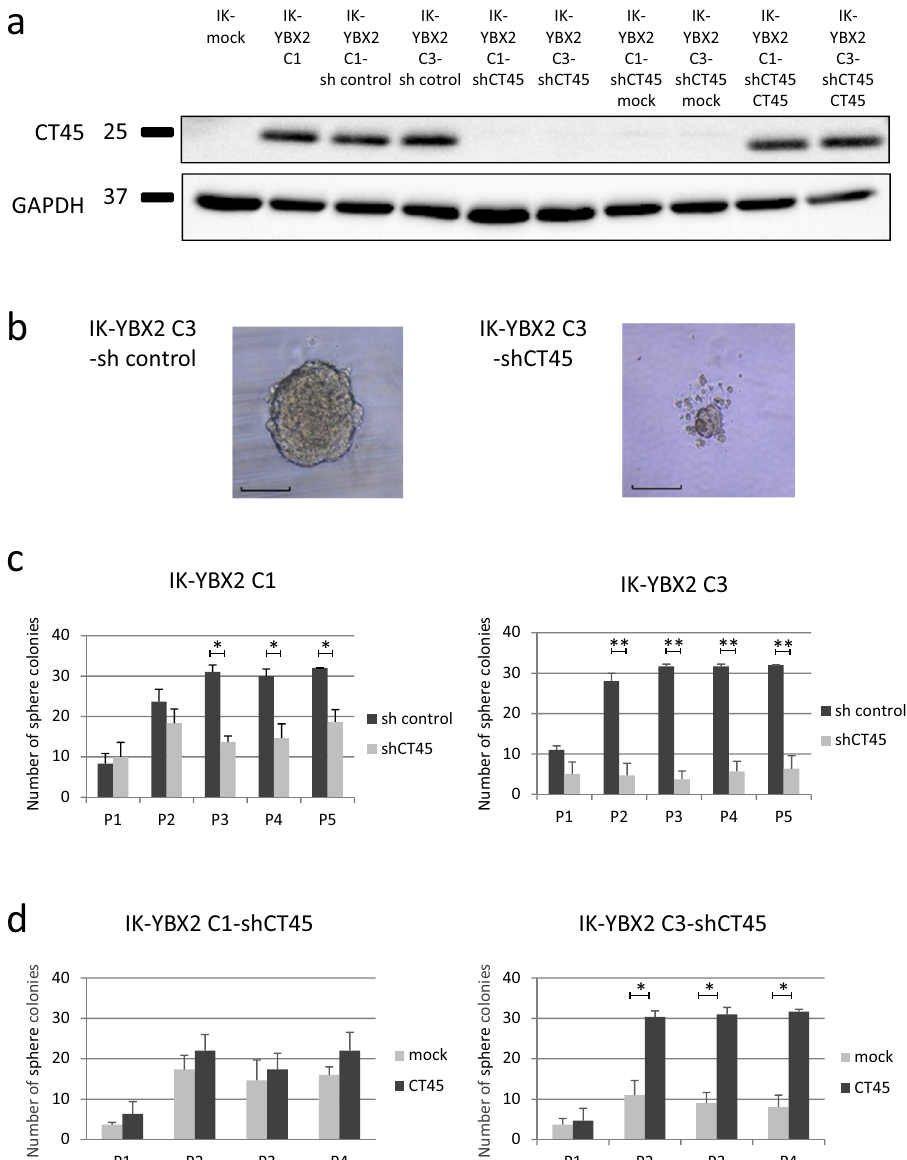
Figure 4. Effects of CT45 expression on self-renewal in endometrial cancer cell lines. To investigate of CT45 expression, stable knockdown of CT45 of IK-YBX2 cells and CT45 gene-rescued cells of them were established. ( a ) The level of CT45 expression of established cells was investigated by Western blotting. shRNAs significantly reduced the expression of CT45 (lane 3, 4 vs lane 5, 6), and the proteins were rescued using relevant gene expression (lane 7, 8 vs lane 9, 10). Full length blots are shown in Supplementary Fig. S5d online. ( b ) The serial spheres formation assays were performed using two different clones of IK-YBX2-shCT45 and IK-YBX2-sh control cells respectively. Representative spheres generated from a single cell after 14 days in non-adherent culture were shown (scale bar 150 μm). ( c ) Sphere formation was counted at passage (P) 1 to 5. The serial sphere forming capacity, was reduced in IK-YBX2-shCT45 cells compared with in IK-YBX2-sh control cells (** p < 0.01, * p < 0.05). ( d ) To exclude off target effect of shRNA, we also established cells which were rescued CT45 expression by introduction of CT45 cDNA into each clone of CT45 knocked down cells. Upon serial passage from P1-P4, IK-YBX2-shCT45-mock cells generated few tumorsphere during passages. Conversely, sphere formation efficiency was increased in IK-YBX2-shCT45-CT45 rescued cells and a significant increase was observed in of IK-YBX2 C3-shCT45-CT45 rescued cells (* p < 0.05). Data represent the means ± SD from three independent